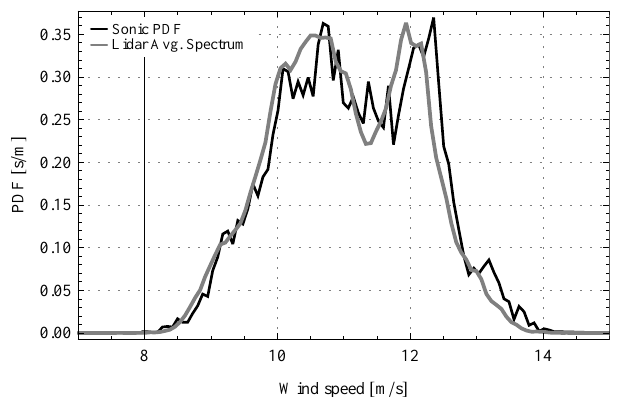
Fig. 1. Comparison of sonic pdf with the corresponding lidar aver- age spectrum for a period of 30min.